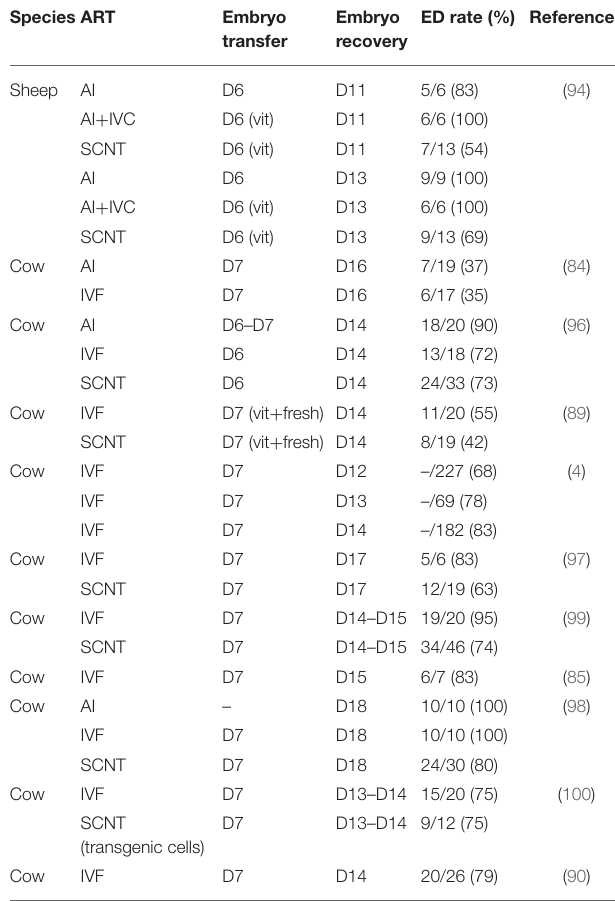
TABLE 2 | Embryonic disc development in embryos produced by assisted reproductive technologies. Species